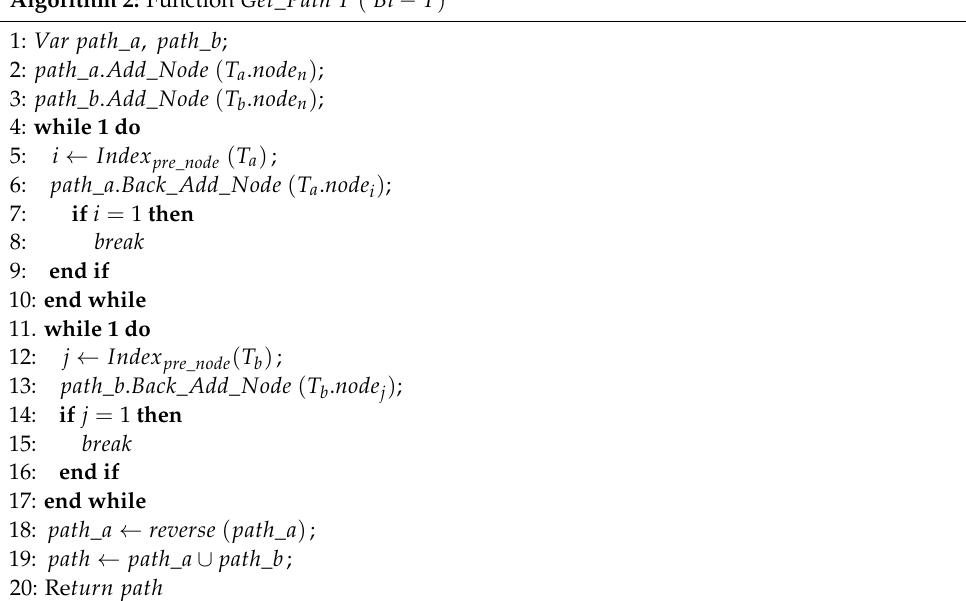
Algorithm 2: Function Get _ Path T ( Bi − T